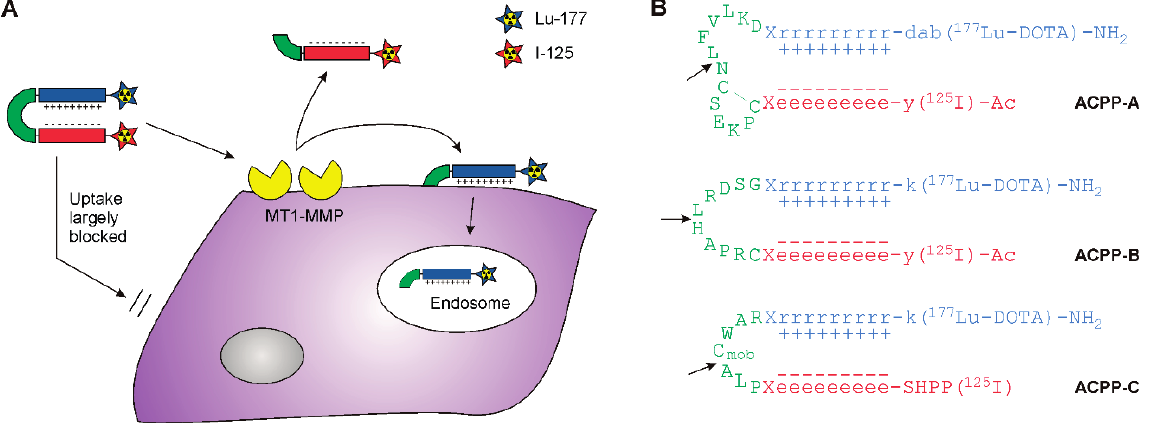
Figure 1. Mechanism and structure of proposed radiolabeled MT1-MMP activatable ACPPs. ( A ) The cell penetrating property of a polycationic peptide (in blue) is masked by a polyanionic peptide (in red). Cleavage of the substrate (in green) by MT1-MMP releases the polycationic cell penetrating peptide, which will transfer the radio-isotope 177 Lu across the cell membrane, while the polyanionic domain together with the radioisotope 125 I will be cleared from the tissue; ( B ) Peptide sequences of the three different MT1-MMP ACPP probes. The arrows indicate the MT1-MMP cleavage sites. In ACPP-A, the two cysteine residues form an intramolecular disulfide bridge. X and SHPP represent 3-oxapentanoic acid (O1Pen) and 3-(4-hydroxyphenyl)propionic acid, respectively. Design considerations for ACPP-C can be found in the supplementary information. The molecular structures of the different probes are presented in Figure